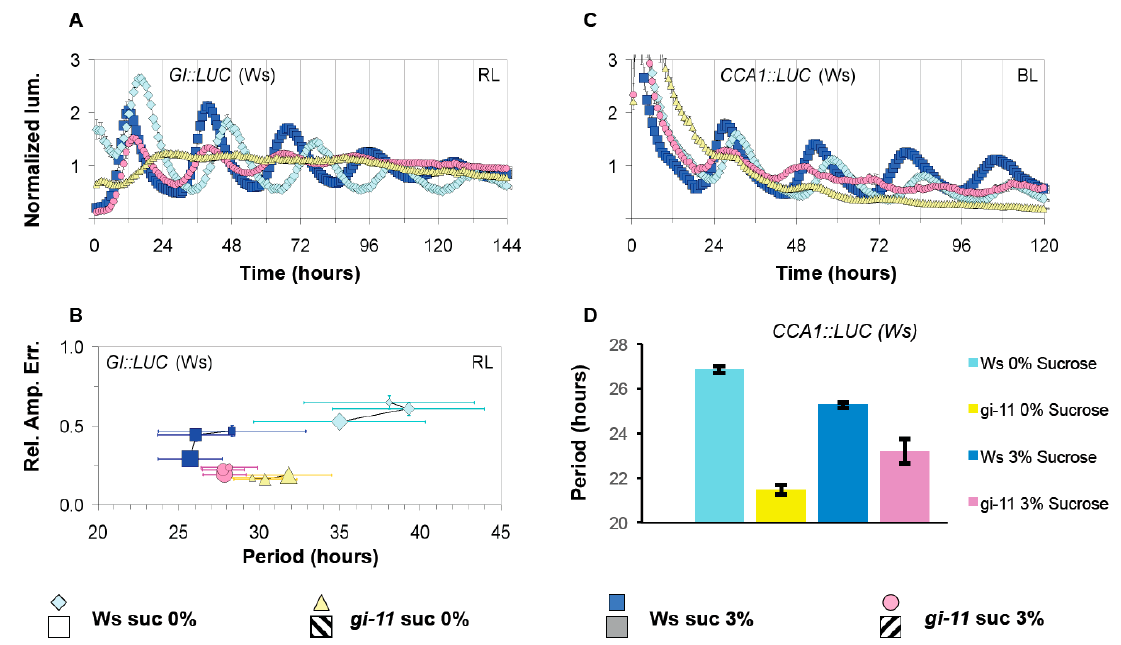
Figure 3. The effect of sucrose on oscillations in the gi-11 mutant. The effect of sucrose on gi-11 GI::LUC ( A ) or gi-11 CCA1::LUC ( C ) oscillations under constant red light or constant blue light, respectively. ( B ) The paired RAE and circadian period of all plants under the different sucrose regimes, calculated as described in Figures 1 and 2. ( D ) Periodicity estimates of (C). Error bars represent SE. Two independent experiments were performed for each respective light condition. Representative experiments are shown in (A,C), while panels (B,D) show combined data from the independent experiments.